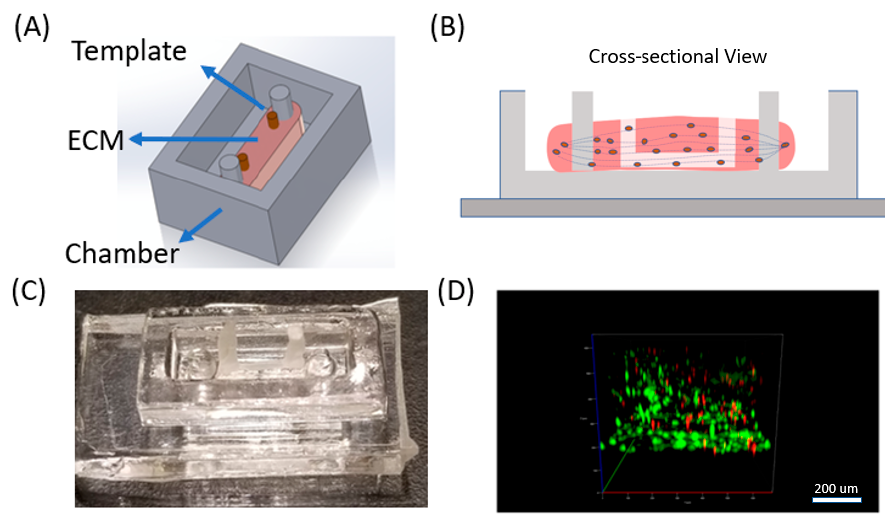
Figure 1. Toward vasculature in skeletal muscle-on-a-chip through themoresponsive sacrificial templates. ( A ) Schematic of general design of device with C2C12 cells cultured in a 3D